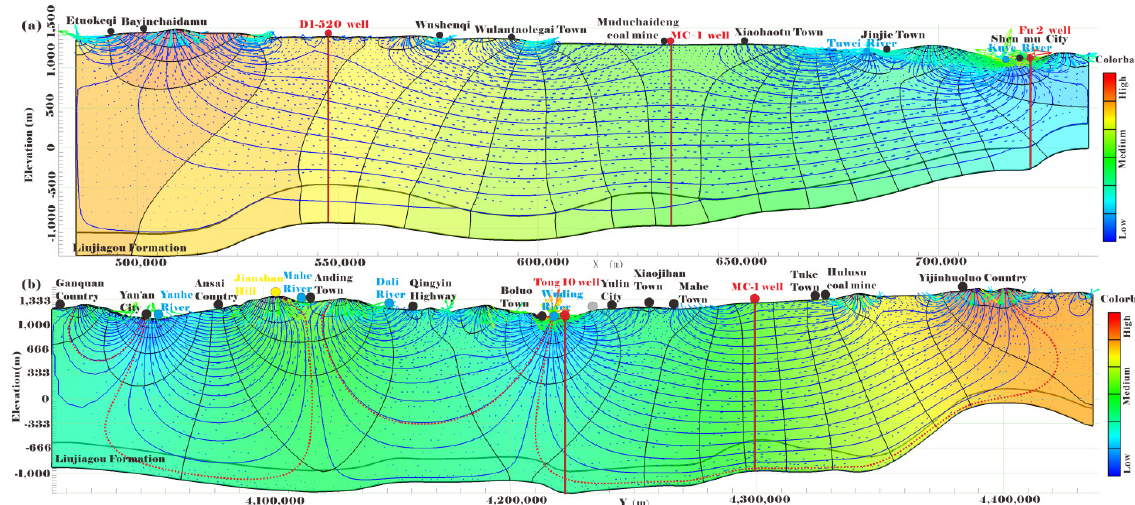
Figure 6. Regional groundwater head and flowline for ( a ) W-E and ( b ) S-N cross-section. The blue line was the groundwater flowline and indicated the groundwater moving path. The small arrow with rainbow color was described the direction and velocity magnitude of regional groundwater. The red arrows were located near the shallow surface or rivers, it is the zone of intensive groundwater circulation. The blue arrows were almost located in the deeper aquifers with the very low flow rate. The black contour shows the groundwater head.